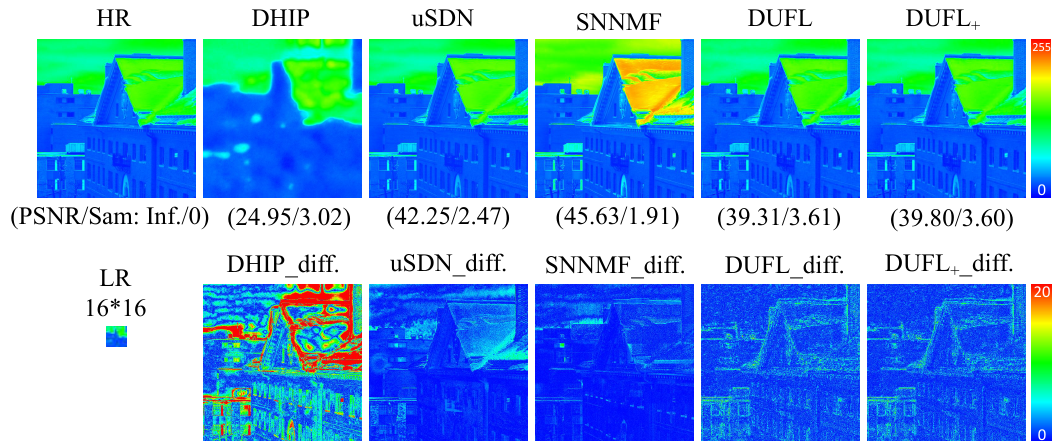
Figure 8. Recovered HR-HS image of the (cid:48) img1 (cid:48) sample in the Harvard dataset using the DHIP [24], uSDN [41], SNNMF [51], and the proposed methods and corresponding difference images between the ground-truth and recovered images with an upscale factor of